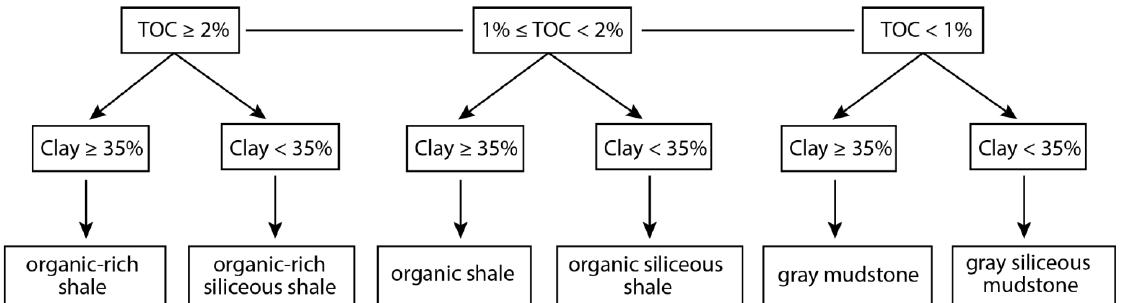
Figure 4. Tree diagram showing the criteria for classifying Gulong Shale